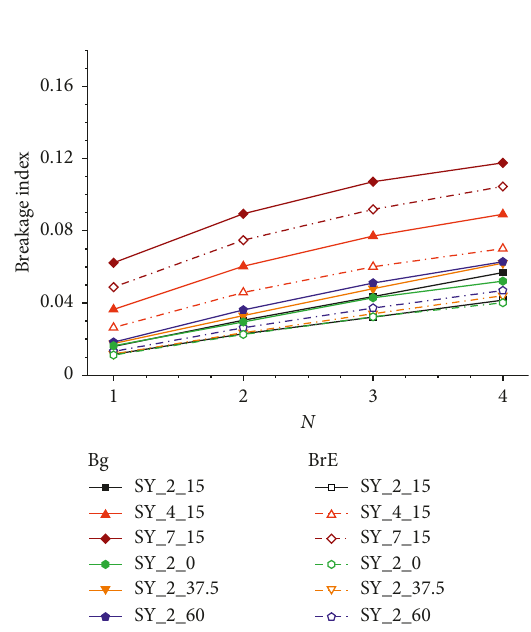
Figure 10: Evolution of GSD: (a) reference group; (b) composite pattern group.